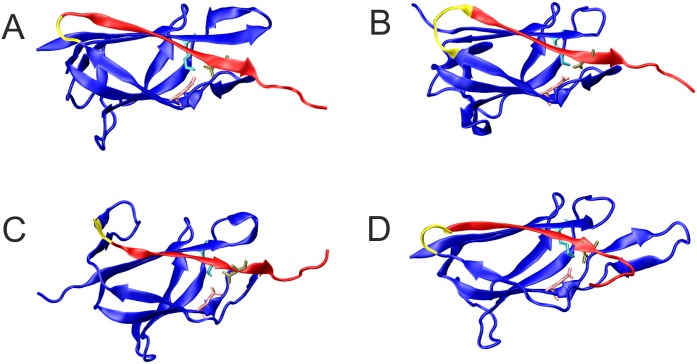
Structures of the CnaB-type domains that served as starting point for the design of the tag/catcher systems.The systems are named according to the PDB entry they were derived from (see Table 1 for details) (A) 3phs; (B) 4oq1; (C) 3kptN; (D) 3kptC. Residues of the tag, catcher, and deleted regions are colored red, blue, and yellow, respectively (see Table 1 for details on the domain boundaries); active-site residues Asn, Lys and Glu are shown as sticks.